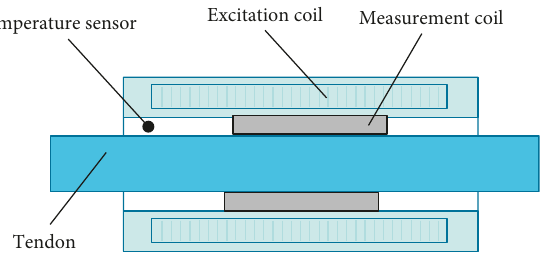
Figure 2: Configuration of an EM sensor.